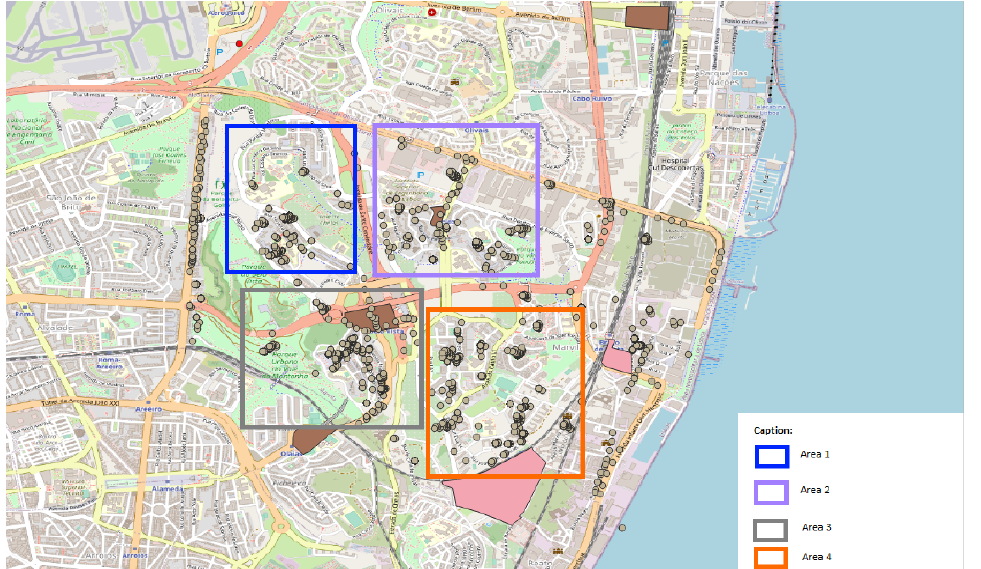
Figure 5. Interesting areas of devices concentration in Marvila . Subway stations—brown; train stations—pink. Background map source: OpenStreetMap